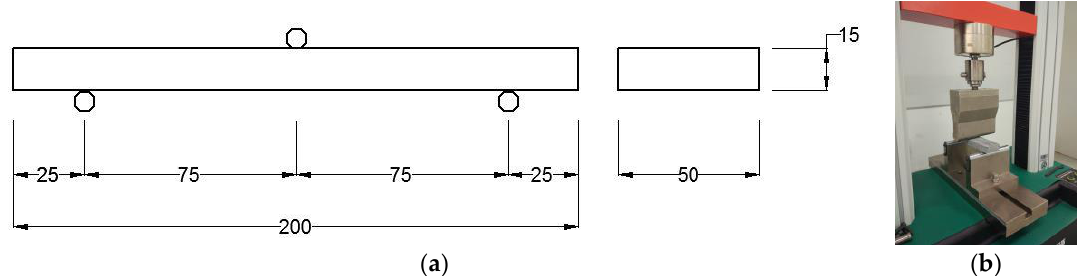
Figure 14. Three-point bending test for the UHPFRC beam. ( a ) Schematic graph (unit: mm) and ( b ) experimental set-up.